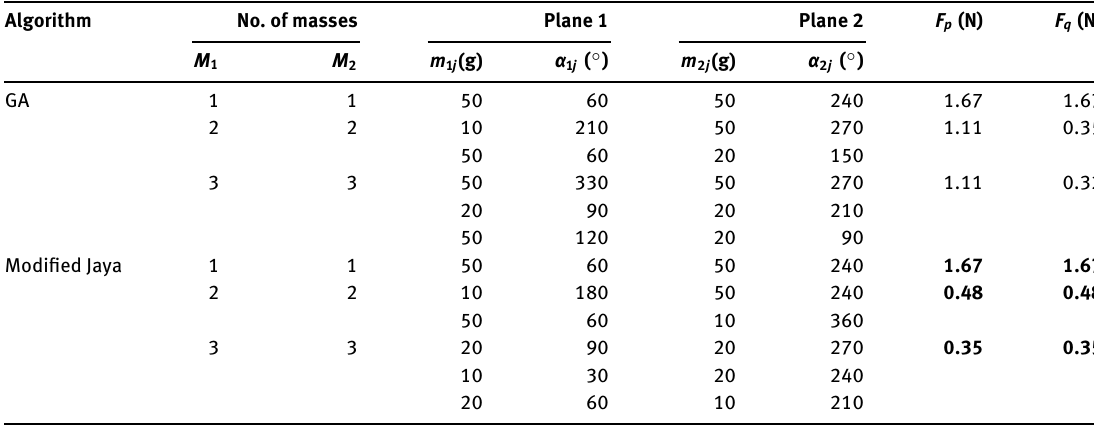
Table 8: Comparison of Optimum Results of Modified Jaya Algorithm to GA [27] for Case 2. Algorithm